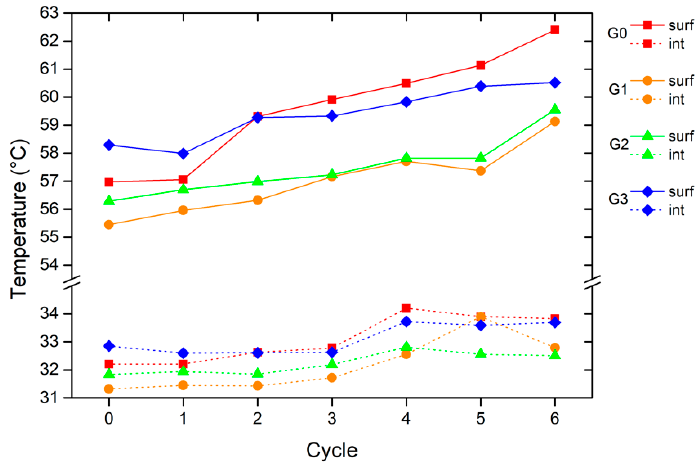
Figure 13. Evolution of the maximum measured T surf and T int as a function of the degradation cycles. However, this phenomenon is not respected by sample G3, containing the spheres